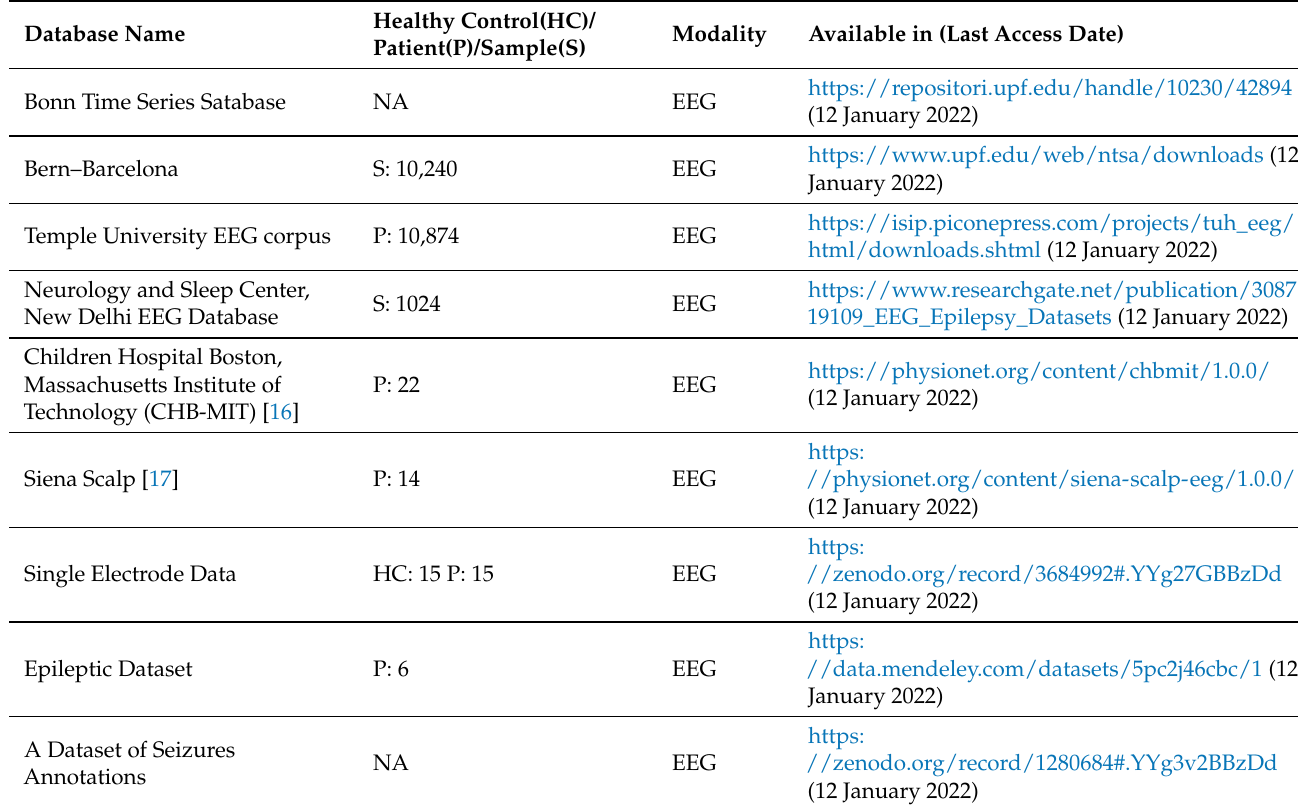
Table 6. A tabulation of popular datasets of epilepsy.